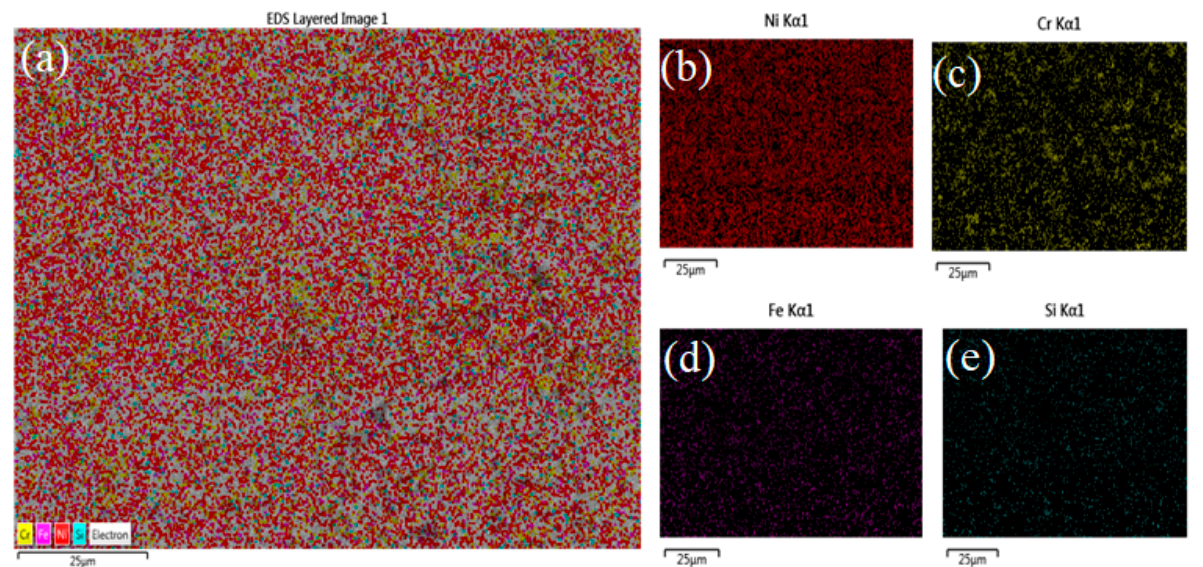
Figure 4. EDS layered image of ( a ) All elements present in the clad region, ( b ) Ni, ( c ) Cr, ( d ) Fe, and ( e ) Si elements.